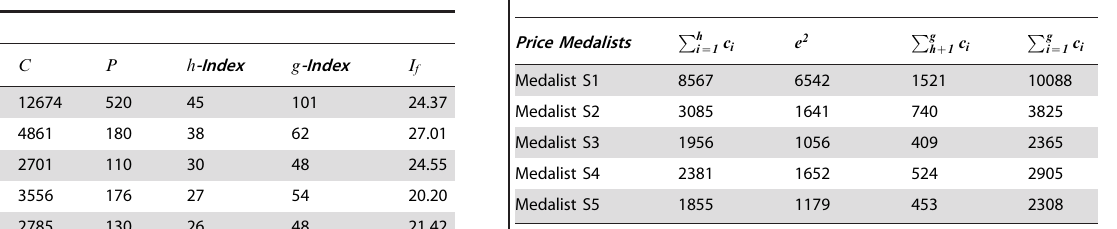
Table 1. The number of citations ( C ), number of papers